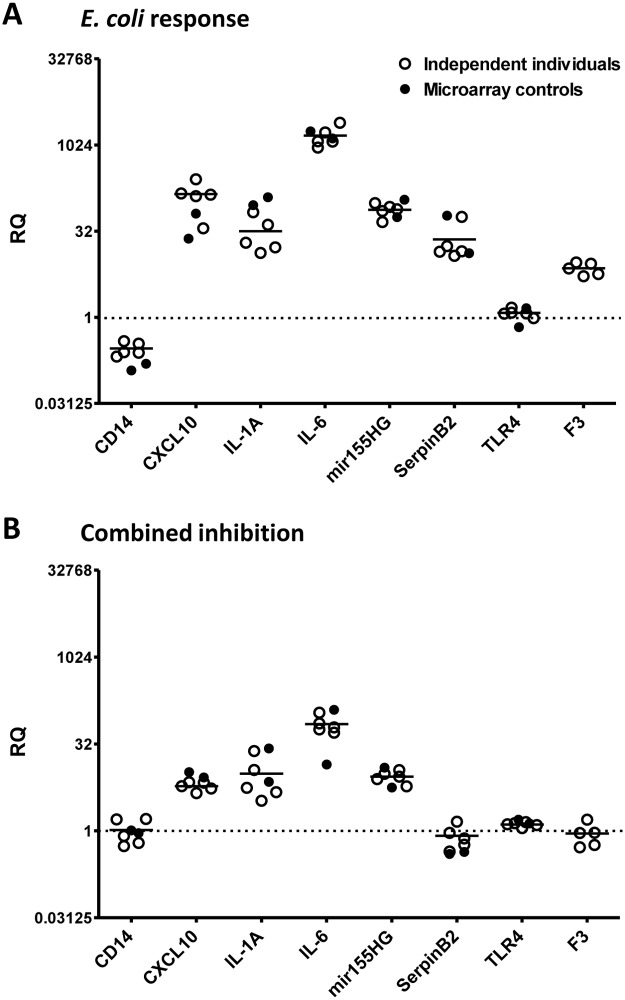
Inter-individual variations of the E. coli response of selected genes.Relative quantification (RQ) data from qPCR analyses are displayed as scatter plots for the E. coli response of seven ERGs and non-responding TLR4 in absence (A) and presence (B) of combined inhibition of C3 and CD14. Data are shown for two sets of data, the controls included in the microarray study (●; single data points, n = 2) and five independent individuals (○; single data points, n = 5 with mean). The expression data were normalized to spontaneous activation in presence of PBS, only, which is indicated as a dotted line crossing the Y-axis (log2 scale) at RQ = 1. No statistical significance of the differences between the two datasets was found for the uninhibited (P = 0.82) and the inhibited response (P = 0.89) in a two-tailed unpaired t-test with Welch’s correction.